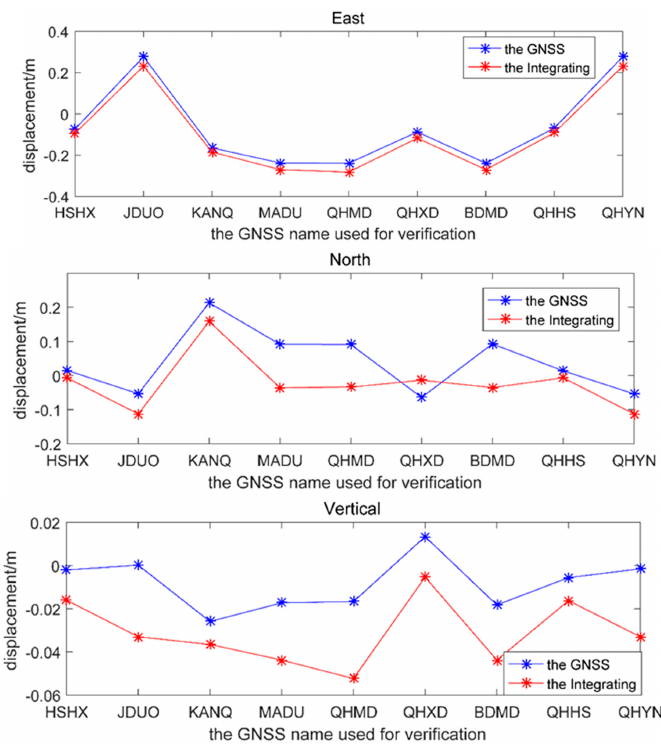
Figure 7. Comparison of GNSS corresponding three-dimensional deformation and the integrated three-dimensional deformation by GNSS and InSAR (the x- axis represents the names of the GNSS station for veri fi cation, the y- axis represents the displacement of the deformation, the red line rep- resents the integrated displacement by the GNSS and InSAR in three directions, and the blue line represents the displacement of the corresponding GNSS stations in three directions).